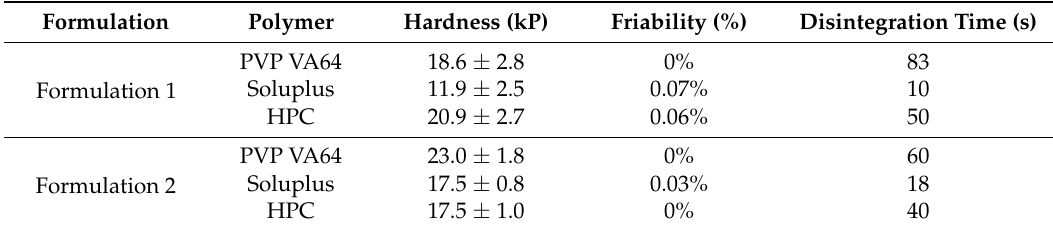
Table 3. Characterization of blank